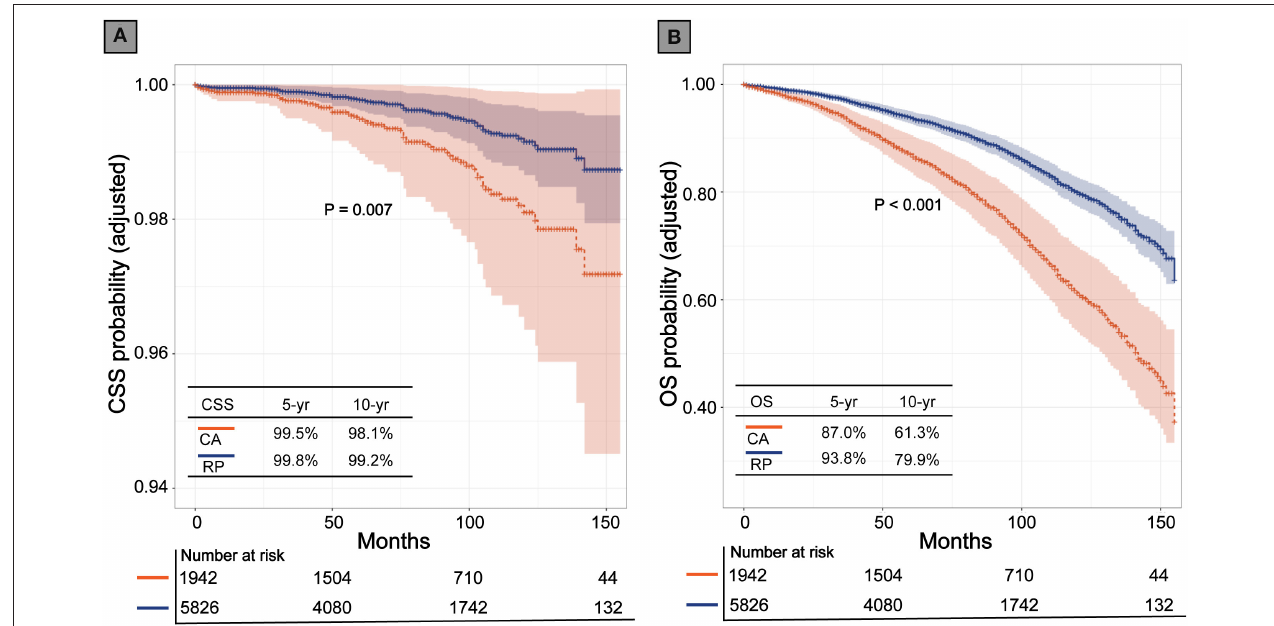
FIGURE 2 | Kaplan-Meier survival curves of cryoablation (CA) vs. radical prostatectomy (RP) after propensity score matching. (A) Cancer specific survival (CSS); (B) Overall survival (OS).